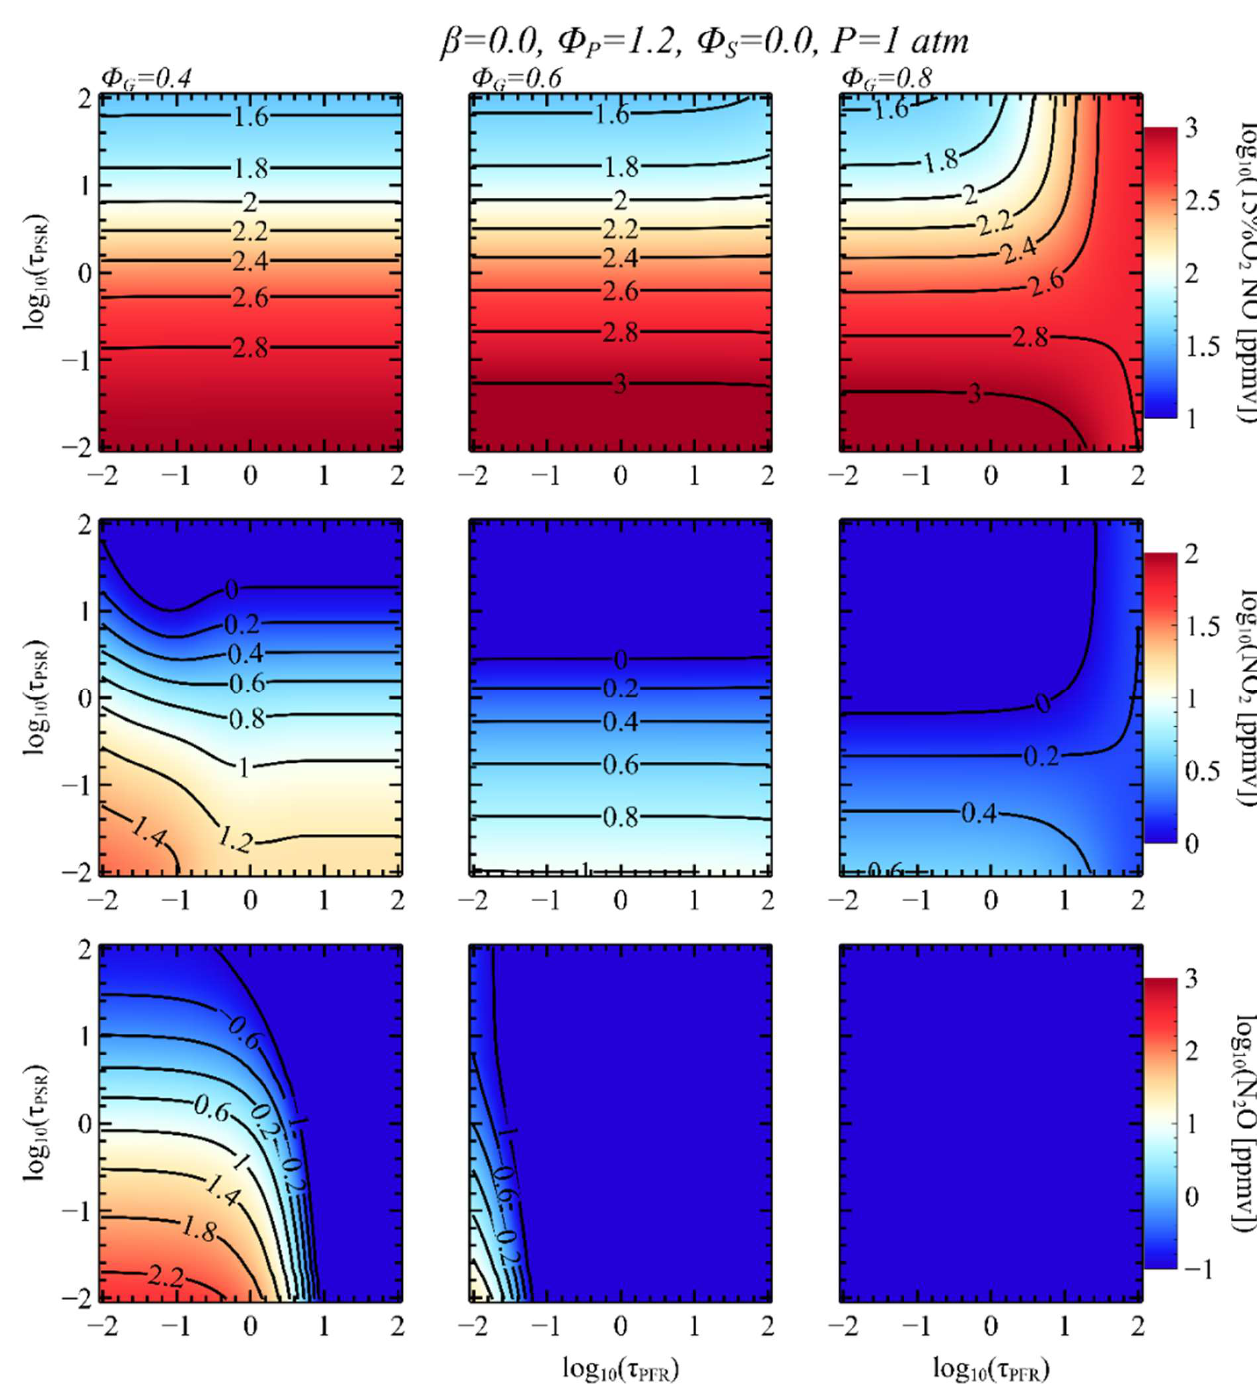
Figure 3. Contour maps of NO x emission in AS CRN. Each column represents computational results with different φ G